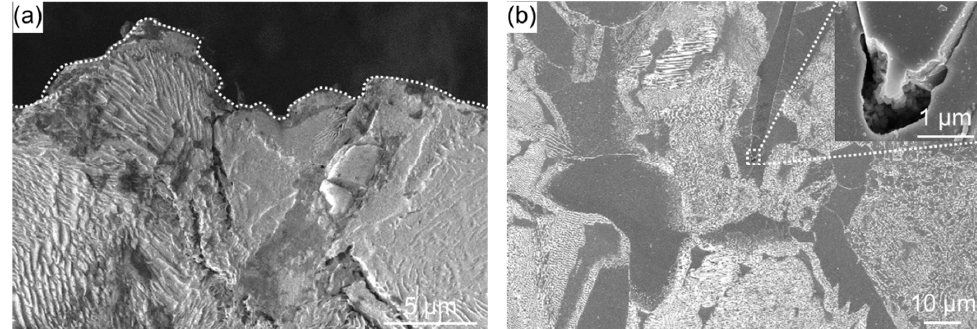
Figure 4. Cross-sectional SEM image of as-received specimen ( a ) near the surface (broken line is the specimen surface) and ( b ) away from the surface. Inset in ( b ) shows an enlarged SEM image of the region indicated by the dashed box.